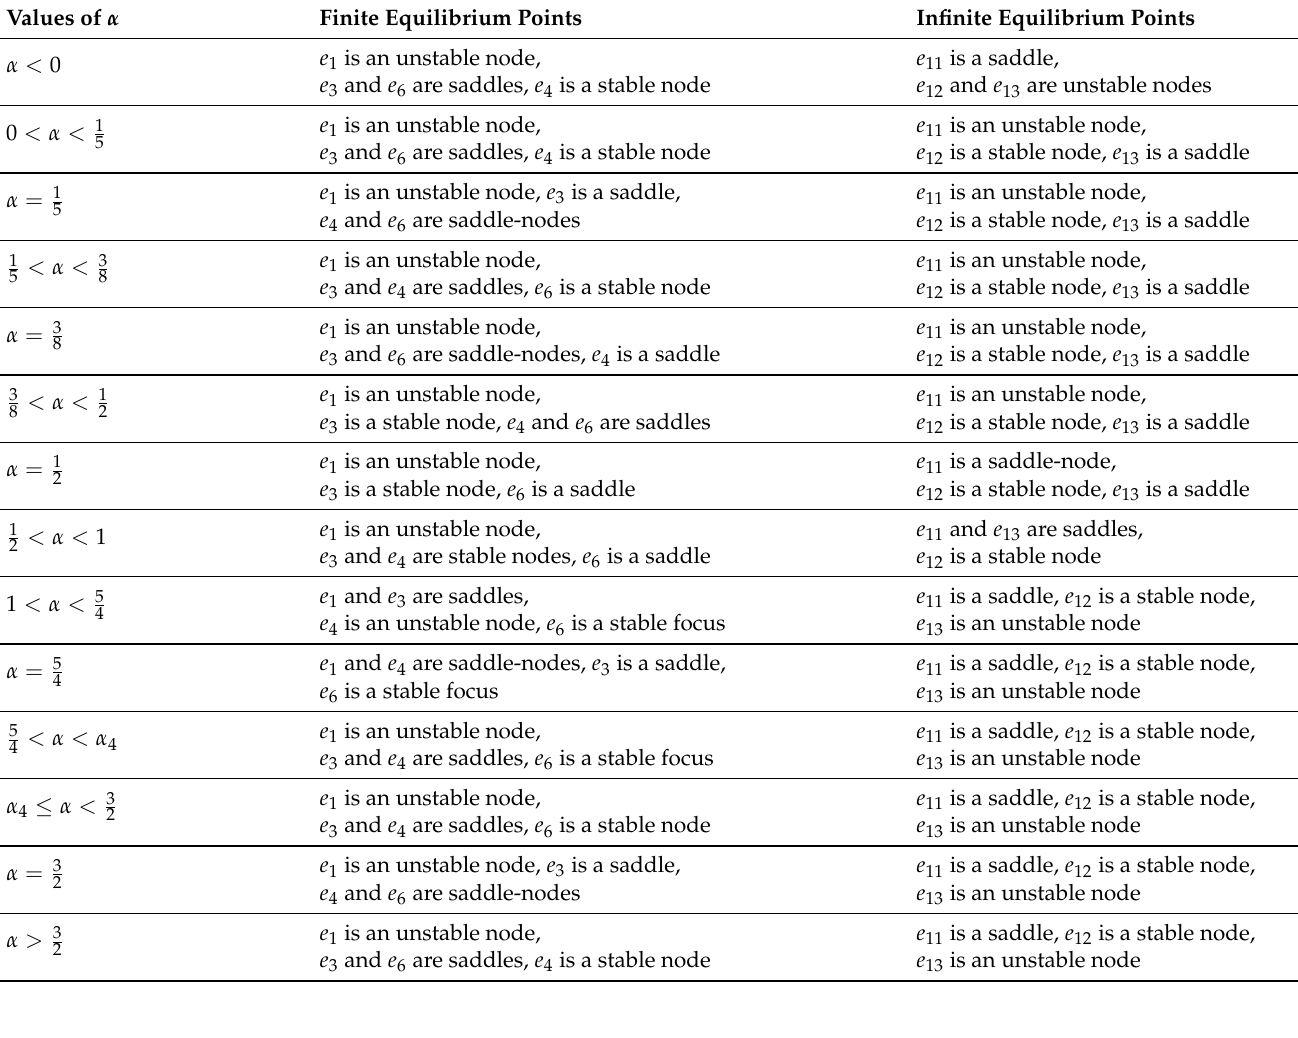
Table 4. Equilibrium points and their types for different values of α of system